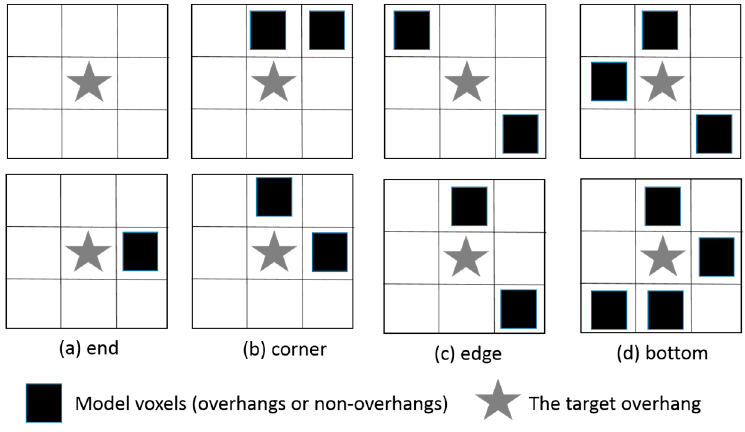
Figure 3. Classification patterns of overhangs: ( a ) end, ( b ) edge, ( c ) corner, and ( d ) bottom overhangs. The star represents the overhang to be classified, and the squares are its neighboring model voxels at the same layer. This figure shows only some representative patterns. Other patterns can be obtained by rotations or by analogy.